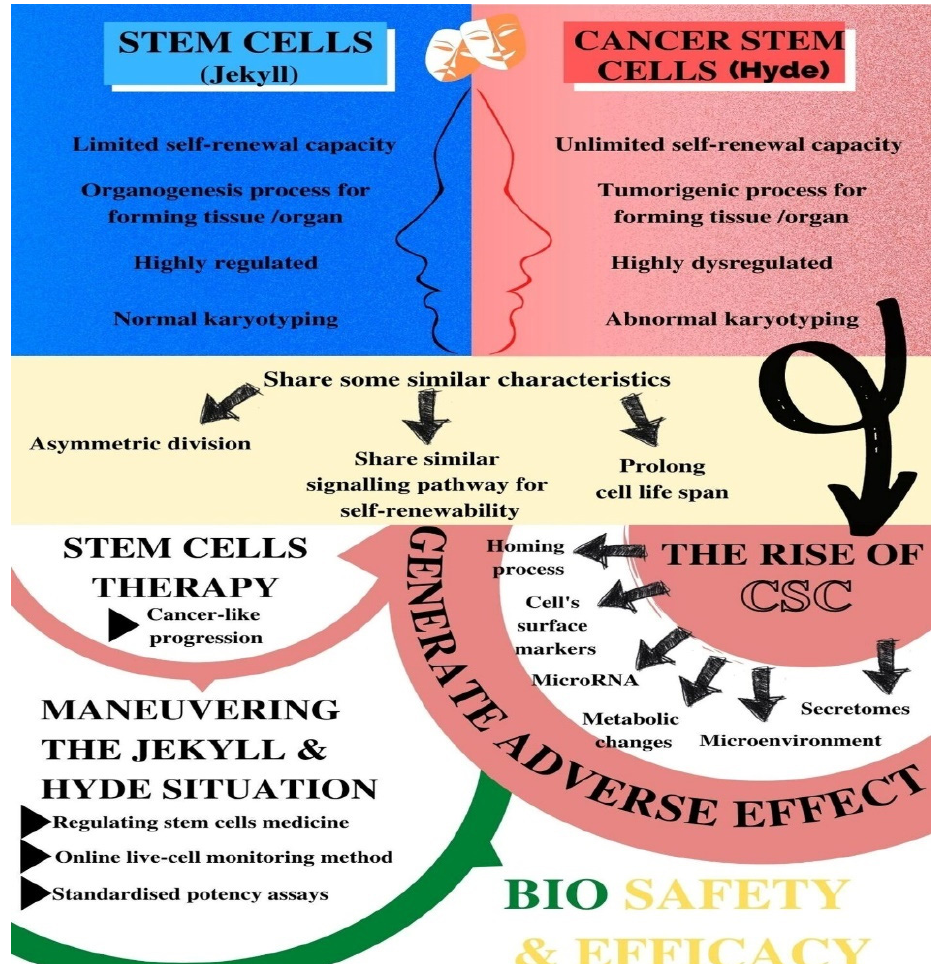
Figure 1. The overview of the “Jekyll and Hyde” scenario between stem cells and cancer stem cells and its implications on stem-cell therapy.